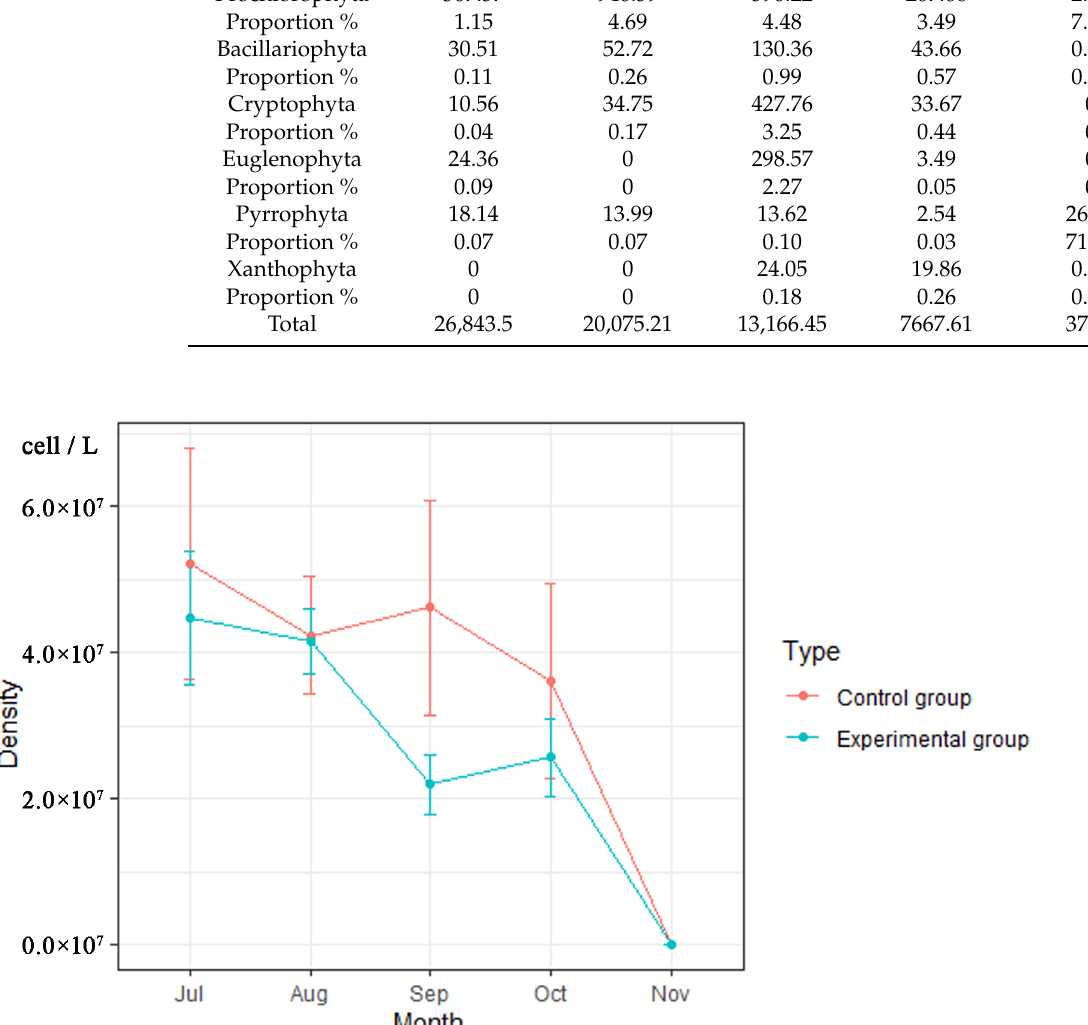
Figure 4. Monthly changes in phytoplankton density in the experimental and control groups. The values and error bars represent means ± SE ( n =